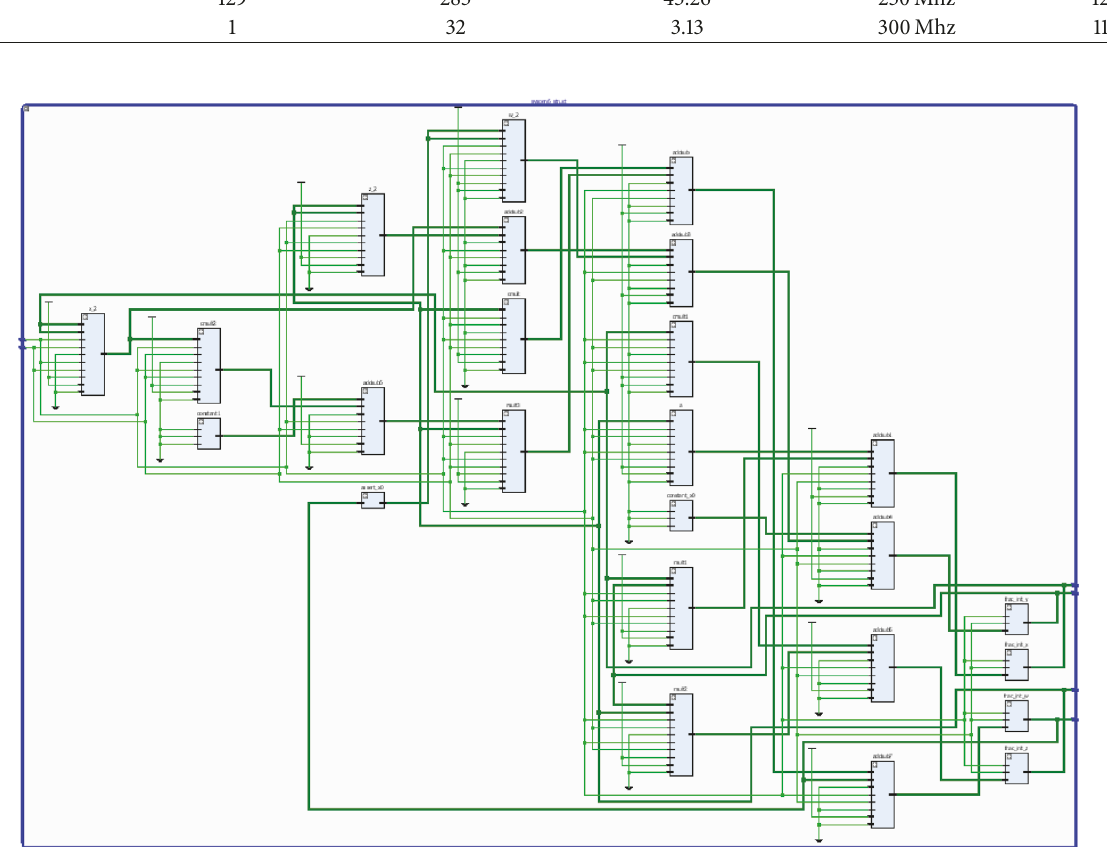
Figure 12: Xilinx RTL schematics of the FOPF system implemented in Kintex 7.